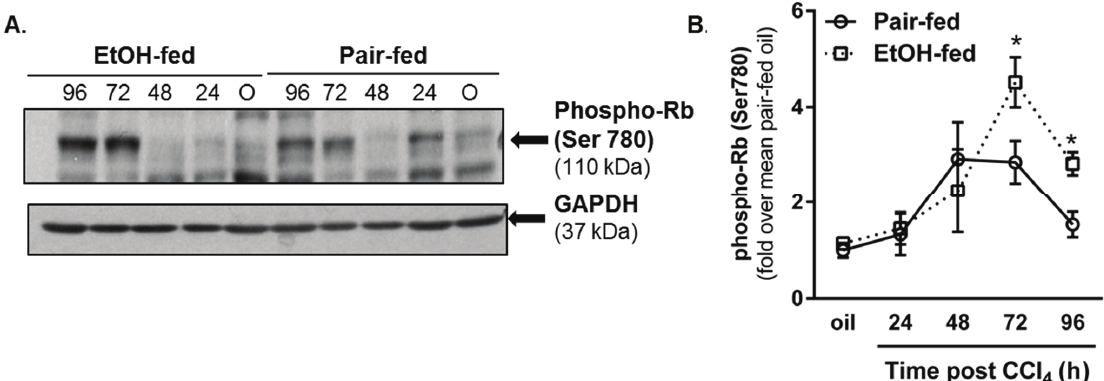
Figure 7. Phosphorylation of the retinoblastoma (Rb) protein was increased by moderate ethanol feeding to mice. Mice on ethanol-containing diets were exposed to CCl 4 and euthanized 24–96 h later. Immunoblots were used to determine hepatic content of phospho-Rb (Ser780) in livers from each mouse. ( A ) Representative phospho-Rb immunoblot. GAPDH was used as a loading control; ( B ) Semi-quantification of band densities from all blots after normalization to GAPDH. Data are graphed as fold change over pair-fed, olive oil-treated mice. N = 4–8 mice per group. * p < 0.05.